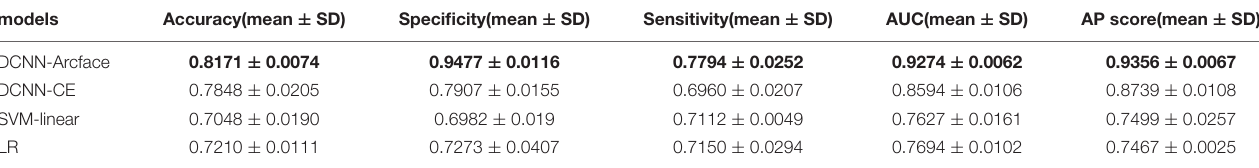
TABLE 4 | The accuracy, specificity, sensitivity, AUC, and AP score of different models at distinguishing Noonan syndrome from patients with several other genetic